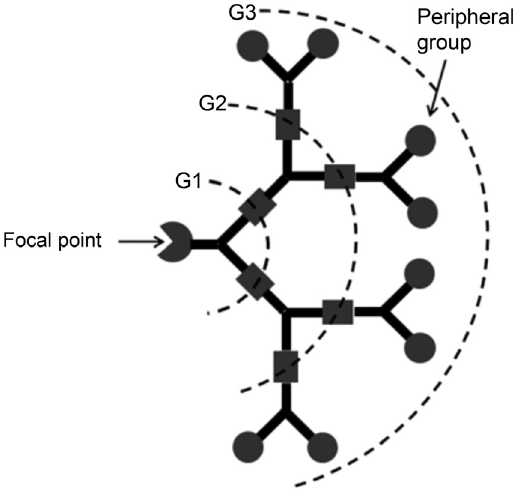
FIGURE 1 - Schematic representation of a dendron showing the focal point, generations (G1, G2, and G3 represent the first, second and third generations respectively), and peripheral